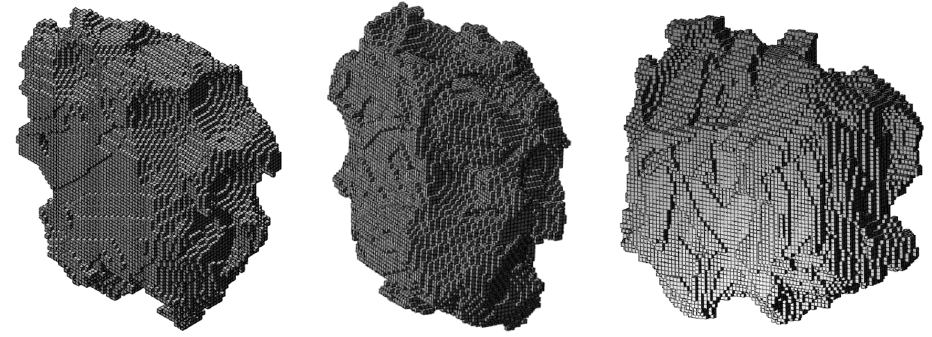
Figure 7. Three views of the exemplary model of an elongated pore with concave boundaries.